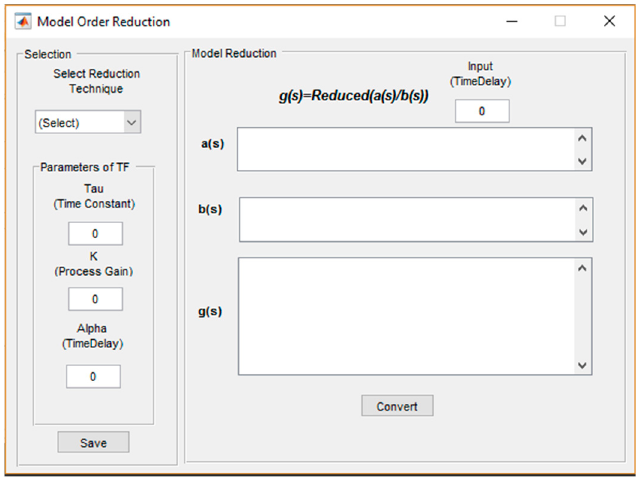
Figure 3. Graphical user interface (GUI) for the model order reduction tool.